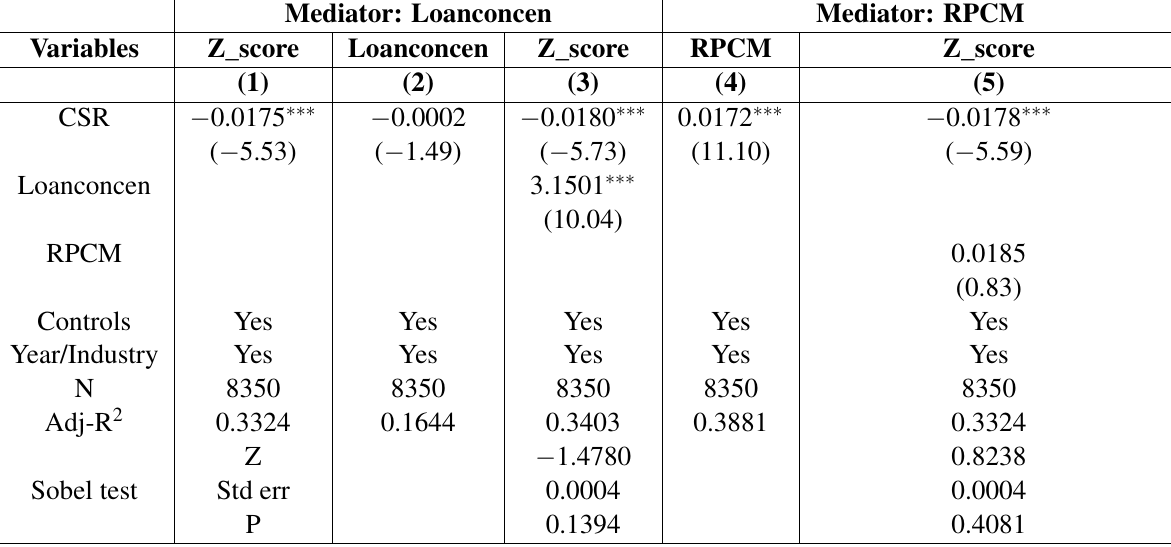
Table 7 Sample of state-owned